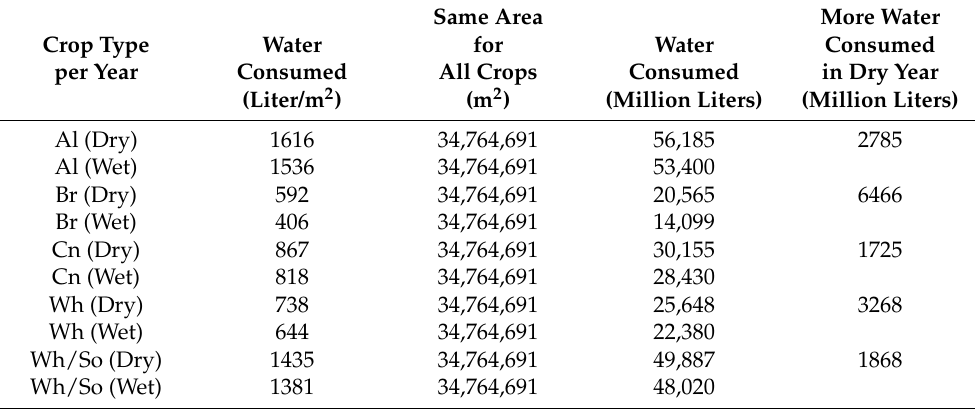
Table 8. Water saving by crops in wet years using a fixed crop area (average area of all crop types) in both dry and wet years (Al = Alfalfa; Br = Barley; Cn = Corn; Ct = Cotton; Wh = Wheat; So = Sorghum). Same Area More Water Crop Type Water for Water Consumed per Year Consumed All Crops Consumed in Dry Year (Liter/m 2 ) (m 2 ) (Million